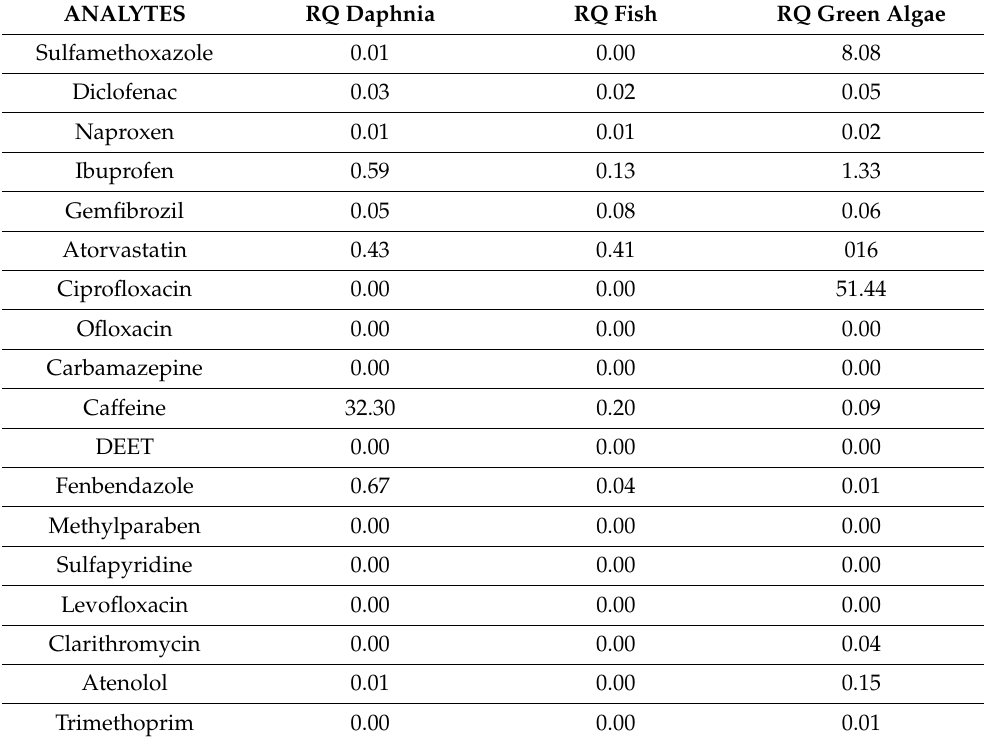
Table 4. Ecological risk assessment of contaminants in the urban wastewater from the Valladolid WWTP. ANALYTES RQ Fish RQ Green